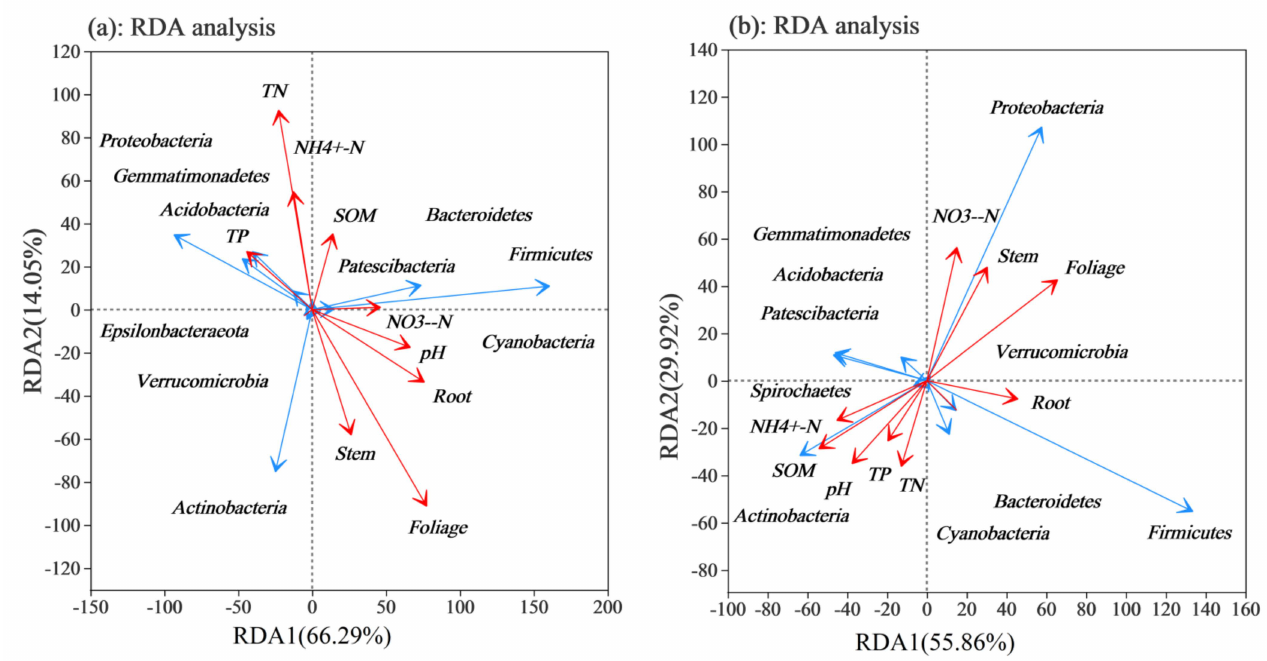
Figure 7. RDA analysis of bacterial communities in the rhizosphere of I. tectorum (( a ) uncontaminated soil ( b ) Cr contaminated soil). The red arrow represents quantitative environmental factors, and the length of the environmental factor arrow can represent the impact degree (interpretation quantity) of environmental factors on species data. The angle between the arrows of environmental factors represents positive and negative correlations (acute angle: positive correlation; obtuse angle: negative correlation; right angle: no